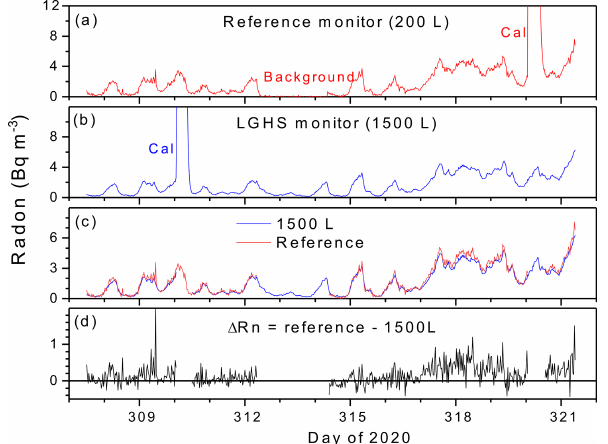
Figure 13. 30min time series of calibrated radon concentrations from (a) the reference, and (b) the 1500L monitors. All valid ob- servations are directly compared in (c) and (d) shows the difference in radon concentration between the reference and 1500L monitors (Chambers et al.,